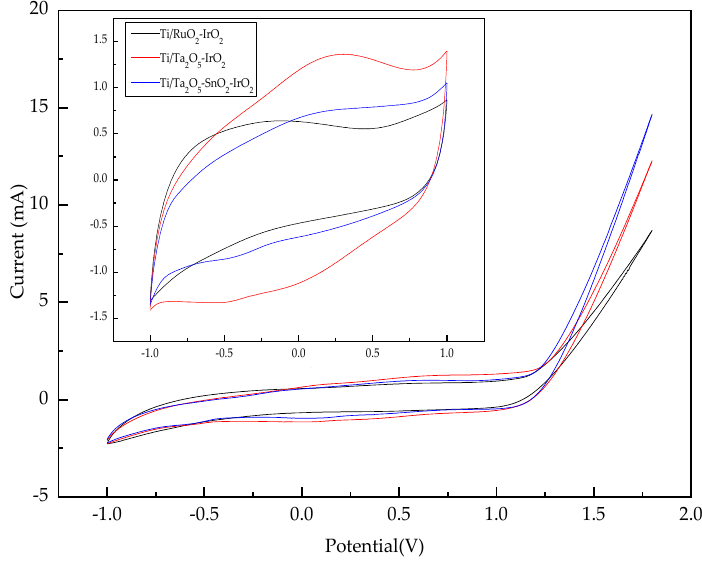
Figure 4. Cyclic voltammetry (CV) curves of three electrodes at a scan rate of 50 mV/s.